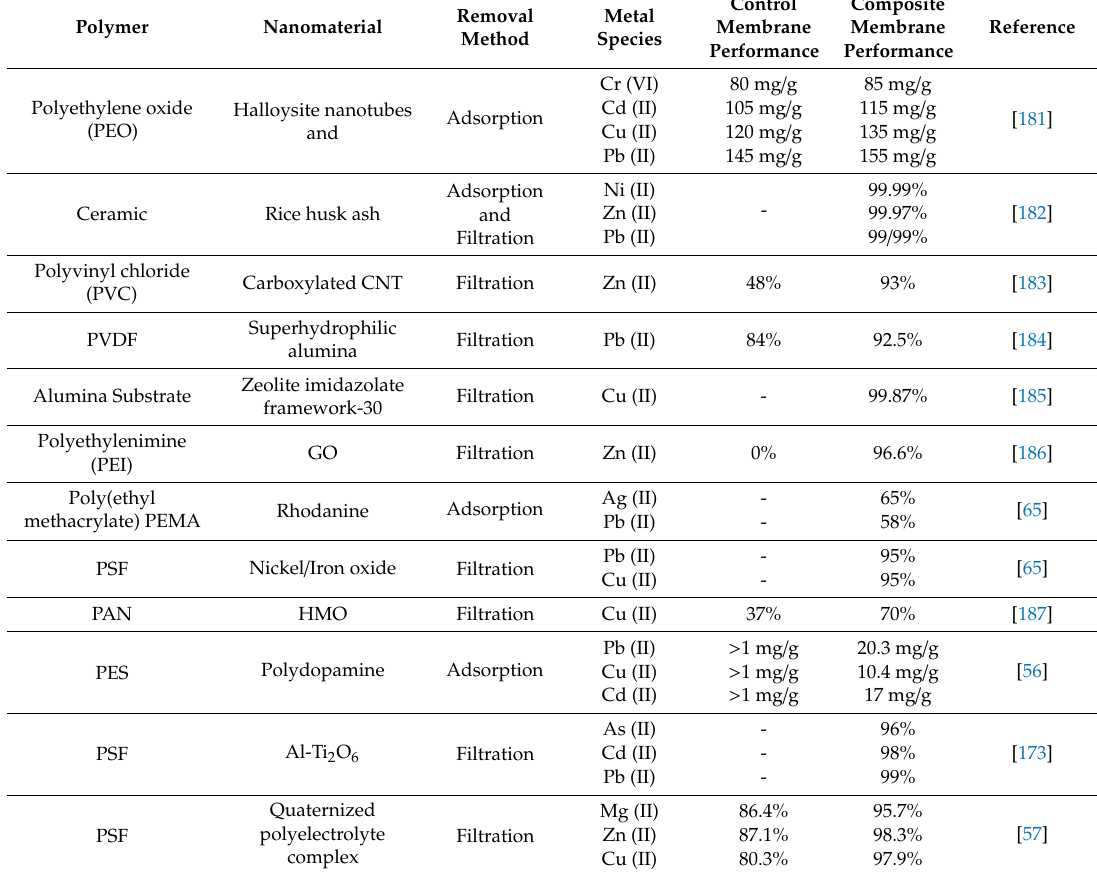
Table 6. Membranes incorporated with nanomaterials for HM ion